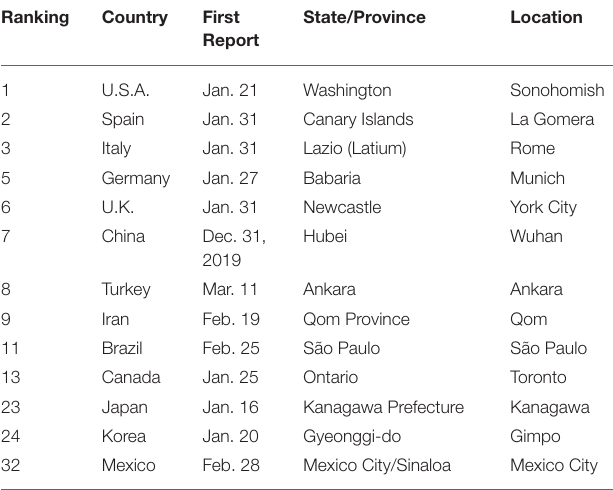
TABLE 1 | Date of reporting the first case, plus the state and location of COVID-19 outbreaks for selected countries. Ranking